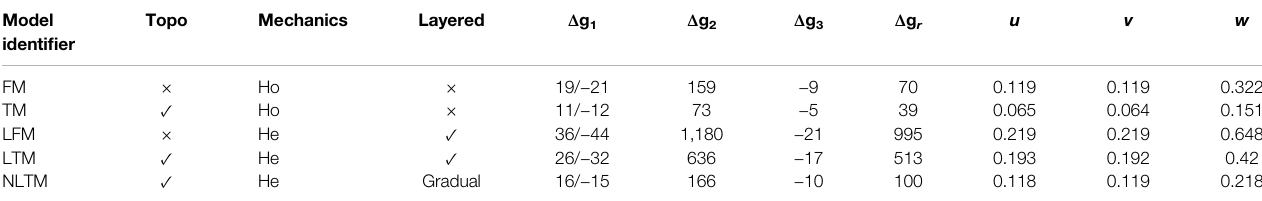
TABLE 4 | Details of3D mechanically homogeneous (Ho) and heterogeneous (He) models developed in this study and results for generic input parameters listed in Table 3 . Δ g Δ g Δ g 1 , 2 , and 3 are the maximum magnitudes of the three different contributions of gravity variations to residual gravity changes u , v and w are maximum eastward, northward and vertical displacements (in m), respectively. See also Figures 5 , 6 for full spatial coverage of model results.